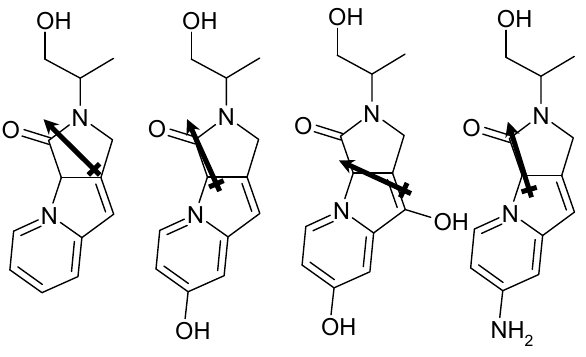
Figure 3. Molecules 1 and 2 orientated with respect to the membrane normal. A qualitative illustration of the ground state static dipole moment for each molecule is shown.